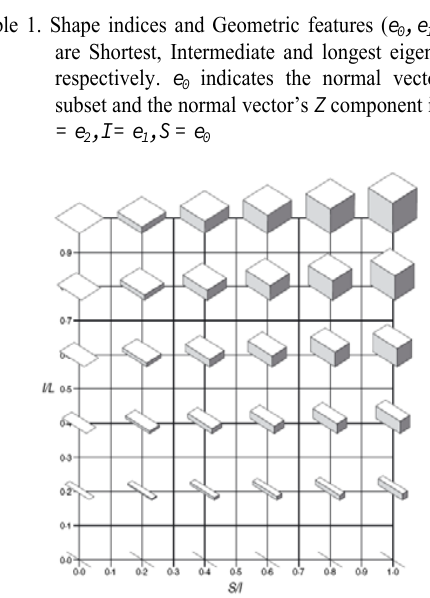
Figure 3. The Zingg (1935) diagram, representing different shape indices (Simon et al. 2008)